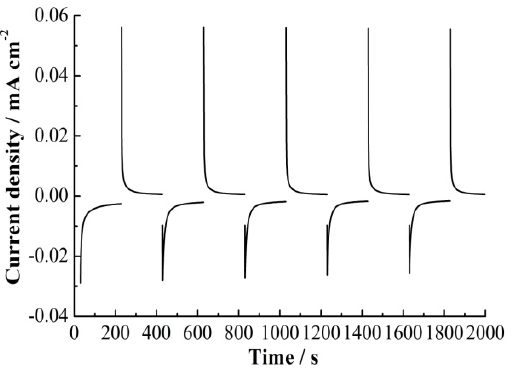
Figure 7. The chronoamperometric response at − 1 and +1 V for an interval of 200 s and a total period of 2000 s of the as ‐ grown APCVD V 2 O 5 at 550 °C.